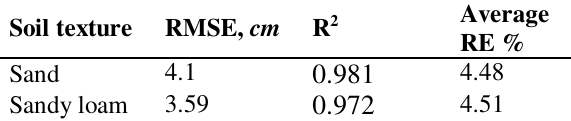
Statistical analysis of the comparison between wetting patterns depth obtained by using HYDRUS/2D and those predicted by the empirical formulas.